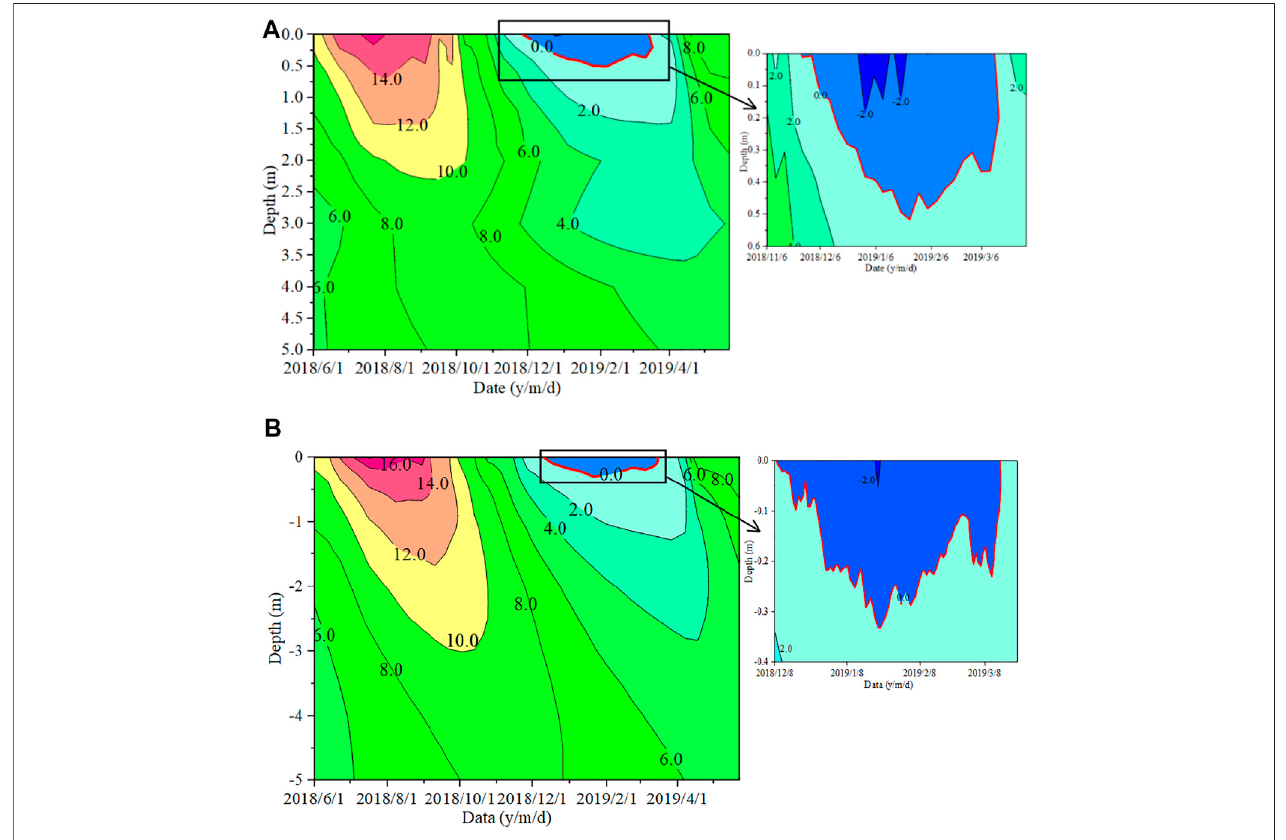
FIGURE 4 | Contour graph of subsurface temperature. (A) Data from the Qiujilangwa village monitoring site; (B) data from the Duoma village monitoring site.